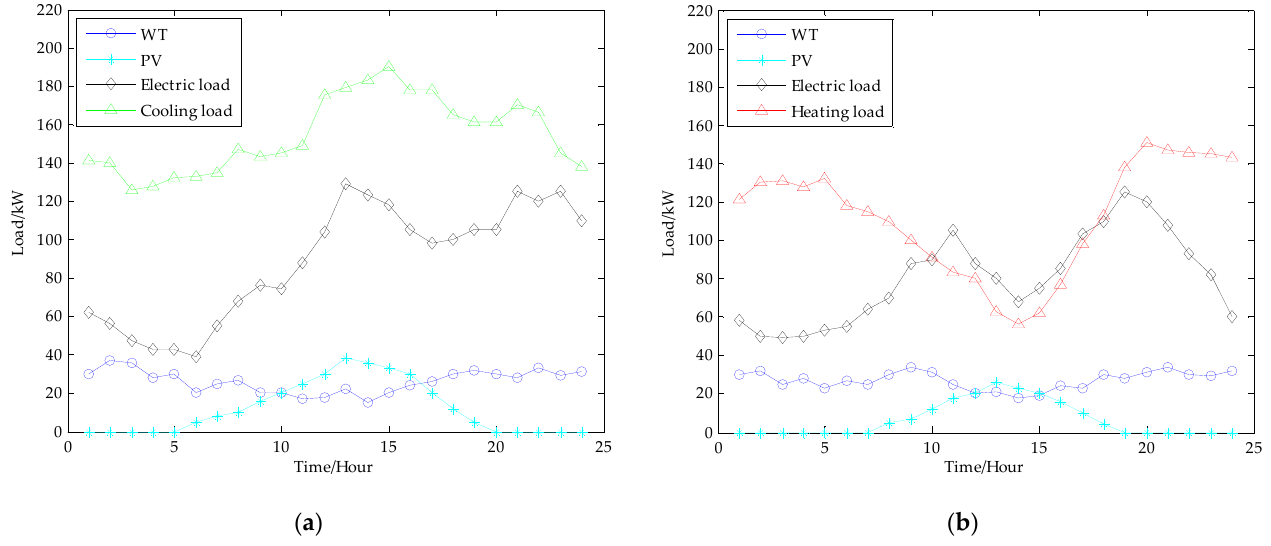
Figure 3. Typical daily load and predicted power of PV and WT: ( a ) summer and ( b ) winter. Table 1. Time of use for the electricity price.